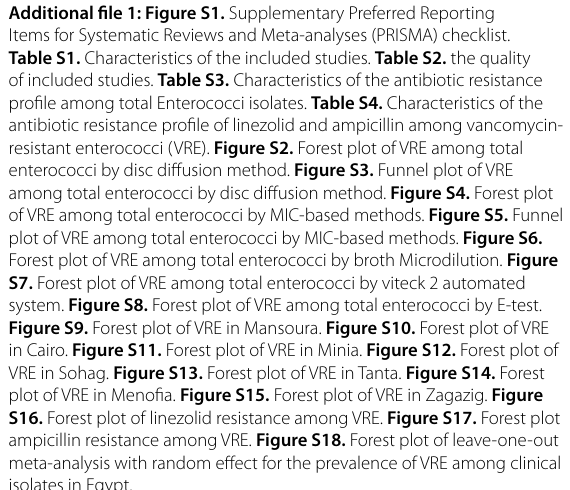
Figure S9. Forest plot of VRE in Mansoura. Figure S10. Forest plot of VRE in Cairo. Figure S11. Forest plot of VRE in Minia. Figure S12. Forest plot of VRE in Sohag. Figure S13. Forest plot of VRE in Tanta. Figure S14. Forest plot of VRE in Menofia. Figure S15. Forest plot of VRE in Zagazig. Figure S16. Forest plot of linezolid resistance among VRE. Figure S17. Forest plot ampicillin resistance among VRE. Figure S18. Forest plot of leave-one-out meta-analysis with random effect for the prevalence of VRE among clinical isolates in